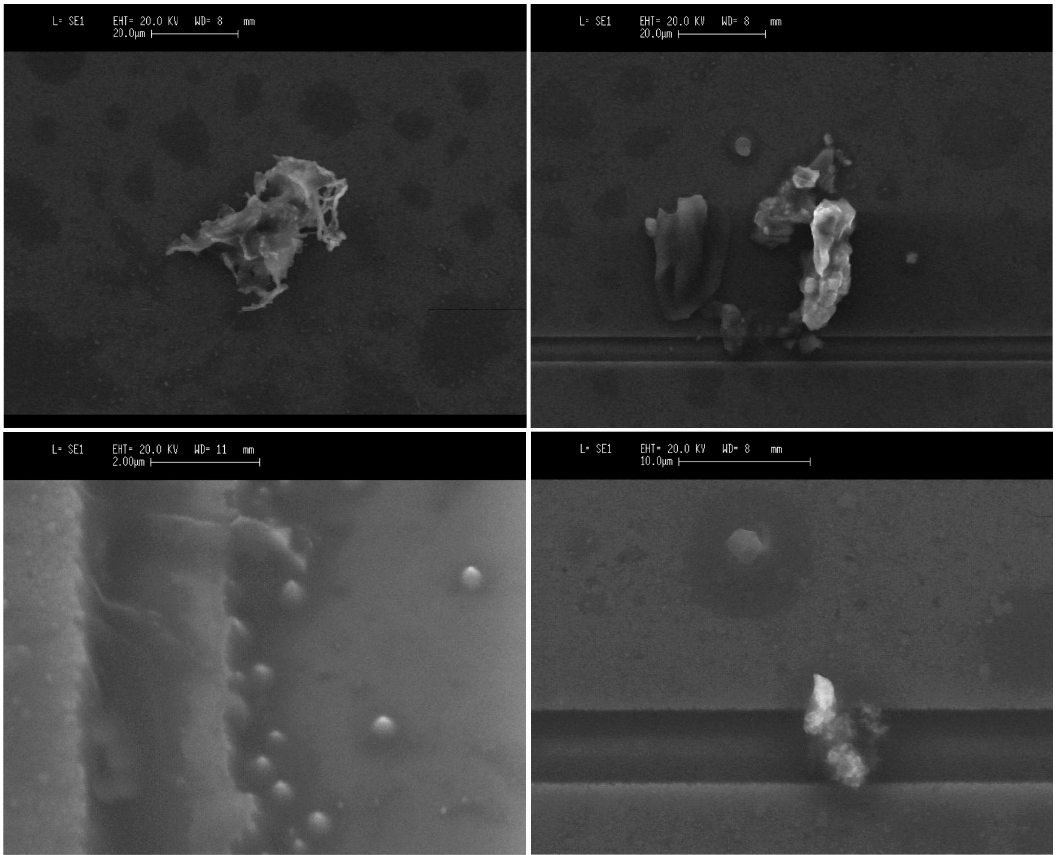
Figure 12. Micrographs of different cigarette particles deposited on the surfaces of a piezoelectric resonator.